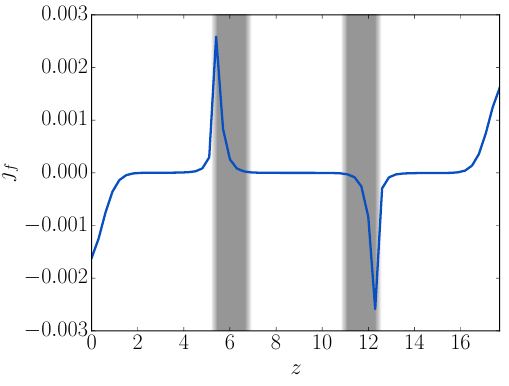
Figure 4 . The fermion current in a typical simulation. q = 0 : 3, (cid:17) = 4, d = 1 :